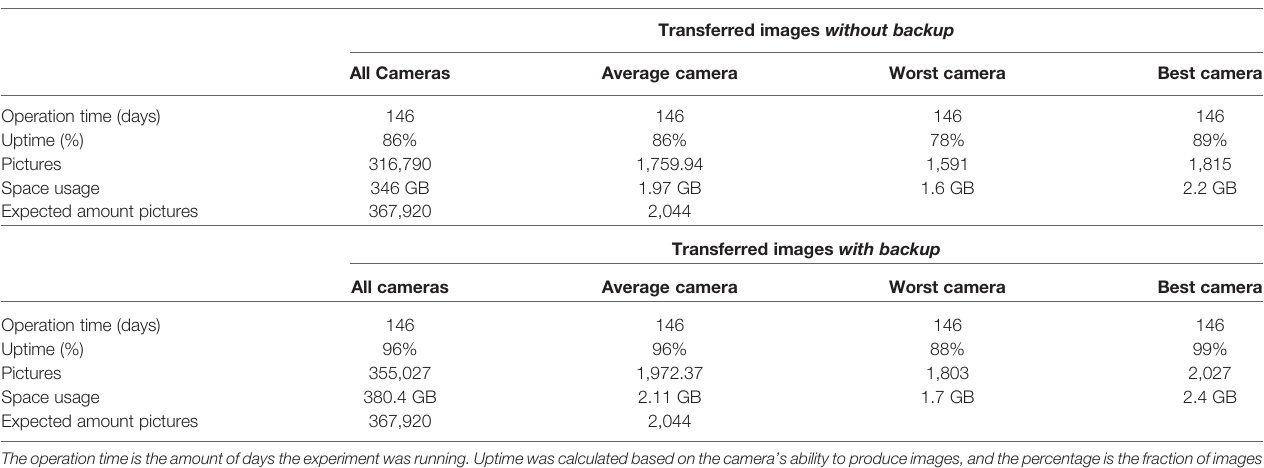
TABLE 1 | Summary of the stability of the phenotyping camera